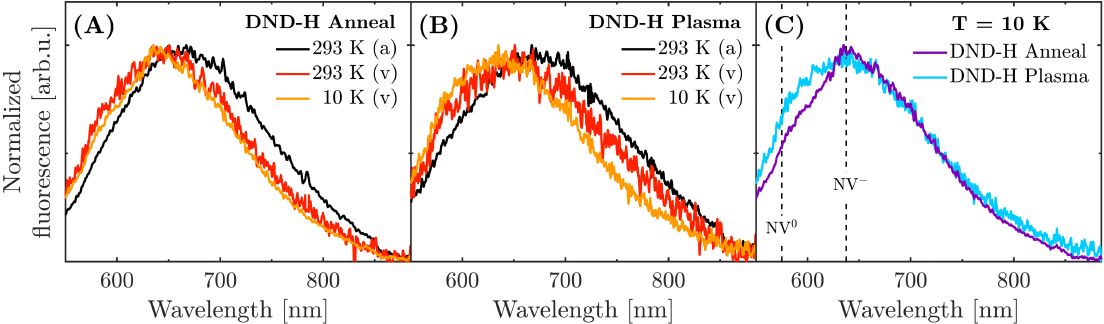
Figure 6. Temperature dependence of the fluorescence spectra of hydrogenated DND particles obtained using 532 nm excitation. Fluorescence spectra of ( A ) DND-H Anneal and ( B ) DND-H Plasma samples at temperatures 293 K and 10 K (in ambient air “a” and vacuum “v”). ( C ) Comparison of DND-H Anneal and DND-H Plasma samples at 10 K. The known spectral positions of the NV center zero-phonon lines are marked by dashed